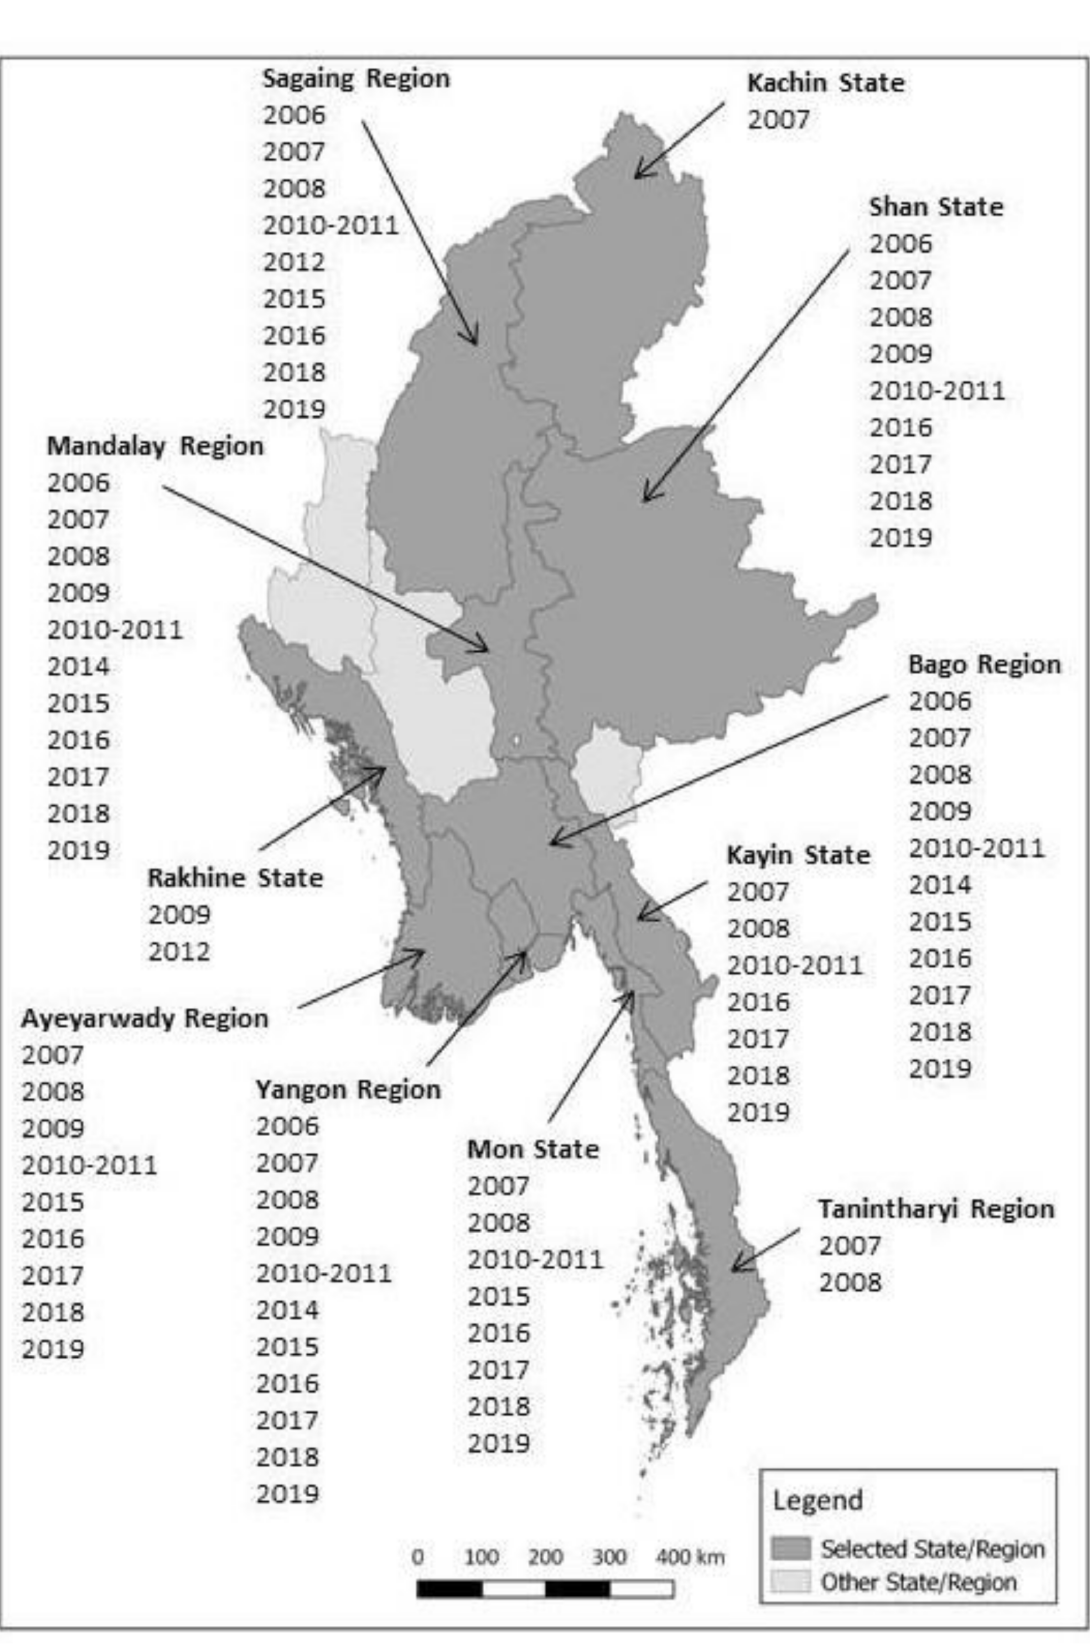
Figure 1. Map of Myanmar States and Regions selected for duck sero-surveillance and years of